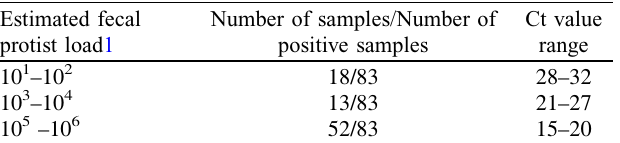
Table 2. Comparison of results of qPCR (Stensvold et al., 2012) and conventional PCR [cPCR] (Sciclune et al., 2006) in detection of